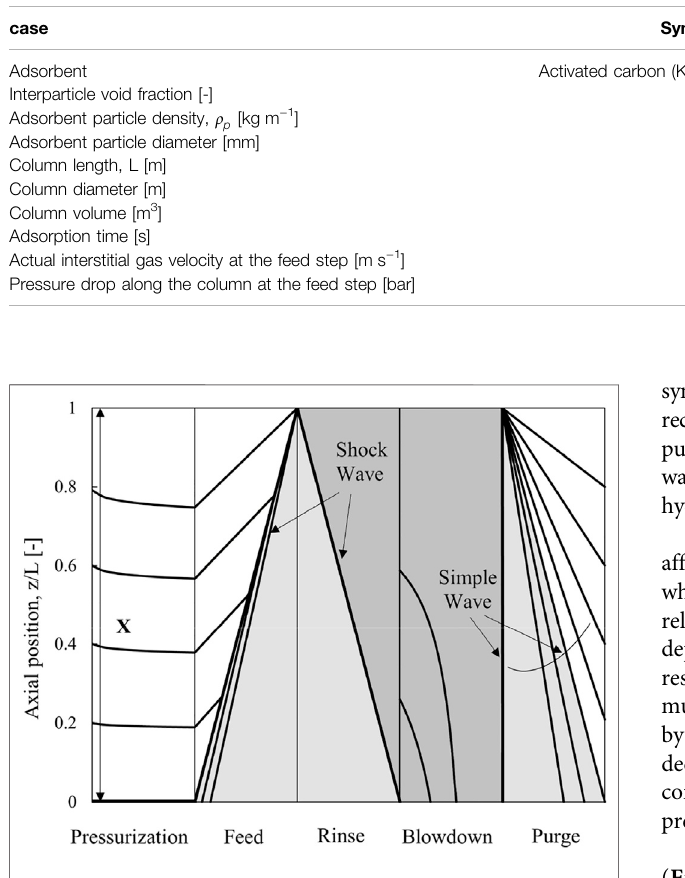
FIGURE 5 | z-t diagram of a fi ve-step VPSA process for syngas capture case.Linesrepresentthecharacteristics.Thelightgreyareaandthedarkgrey area indicate penetration of CO 2 (0 < y < 1) and pure CO 2 (y (cid:1) 1), respectively.